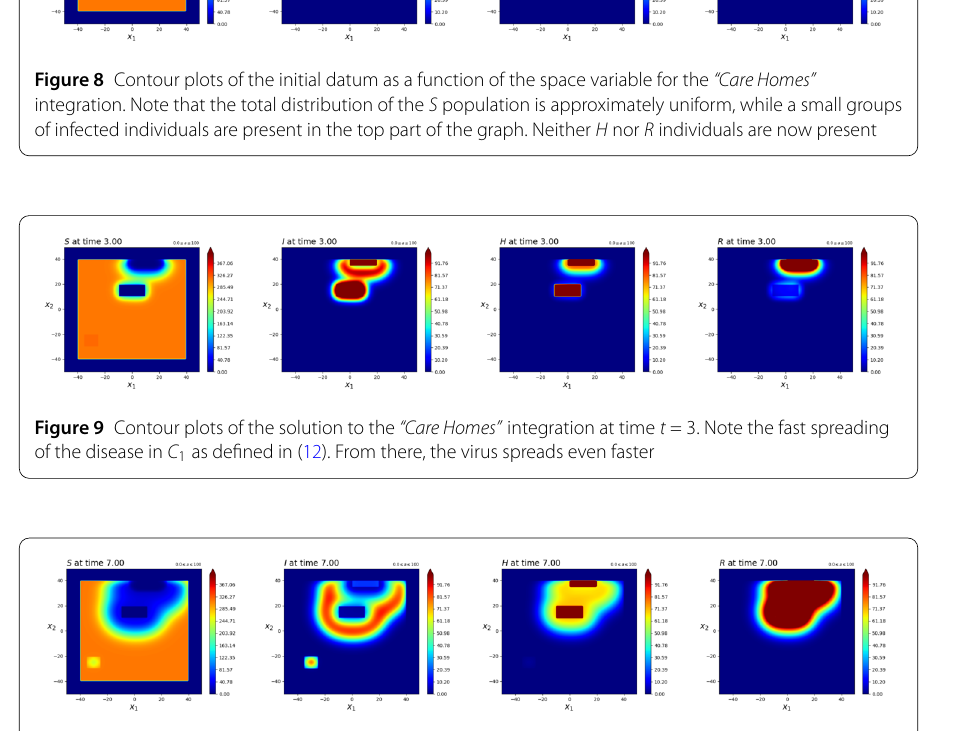
Figure 10 Contour plots of the solution to the “CareHomes” integration at time t = 7. Note that the care house C 2 , as defined in (12), is reached by the virus through a very small amount of I individuals, so small that it is not highlighted with the current scale. Indeed, contrary to the impression suggested by these figures, the model (9) does not allow for any propagation at a distance greater than δ = 5, as specified in (13)